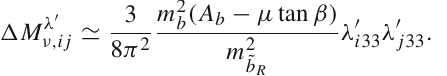
Fig. 3 Model prediction in the δ C 9 vs. r D ( ∗ ) plane for the (cid:16)χ 2 < 2 . 3 (1 σ ) region around the best-fit point. The 1 σ experimental data are shown by the cross. The SM prediction coincides with the origin of the axes (top-left) both anomalies within the RPV framework. Please note, that and λ (cid:4) couplings and thus the fit yields very small λ (cid:4) 233 233 both the second term in (32) and the NP muonic